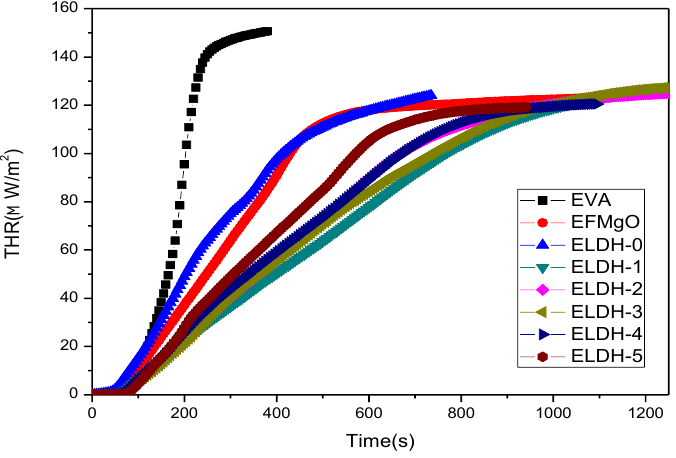
Figure 3. THR of the EVA/LDHs composites.